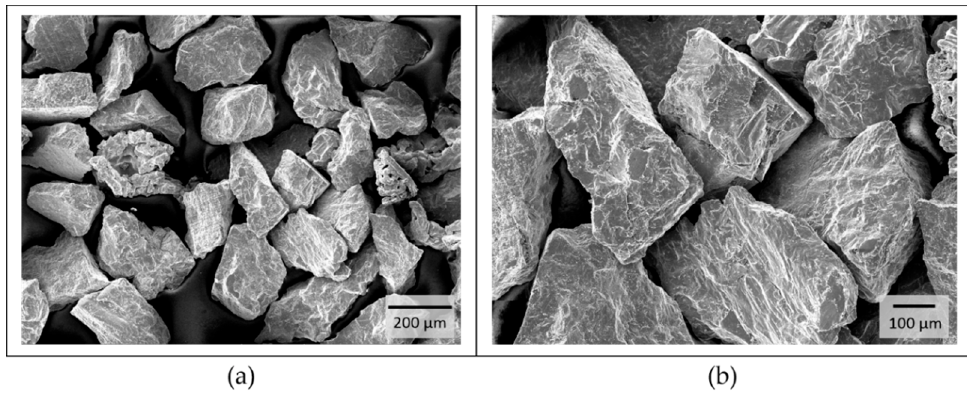
Figure 2. Characterization of the titanium powder morphology. ( a ) particle size: d = 125–335 µm; ( b ) the coarse, sharp-edged and blocky structure.